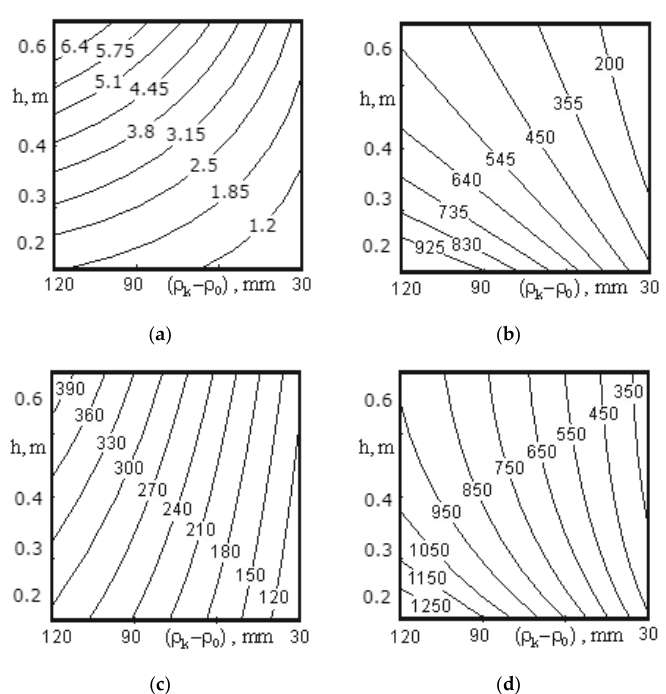
Figure 13. Dependence of the power value on the tape width of the screw and its pitch for the middle screw: ( a ) the surface constructed based on calculations on the first component; ( b ) the surface constructed based on calculations on the second component; ( c ) the surface constructed based on calculations on the third component; ( d ) the surface representing the change in the total power value for all three components.